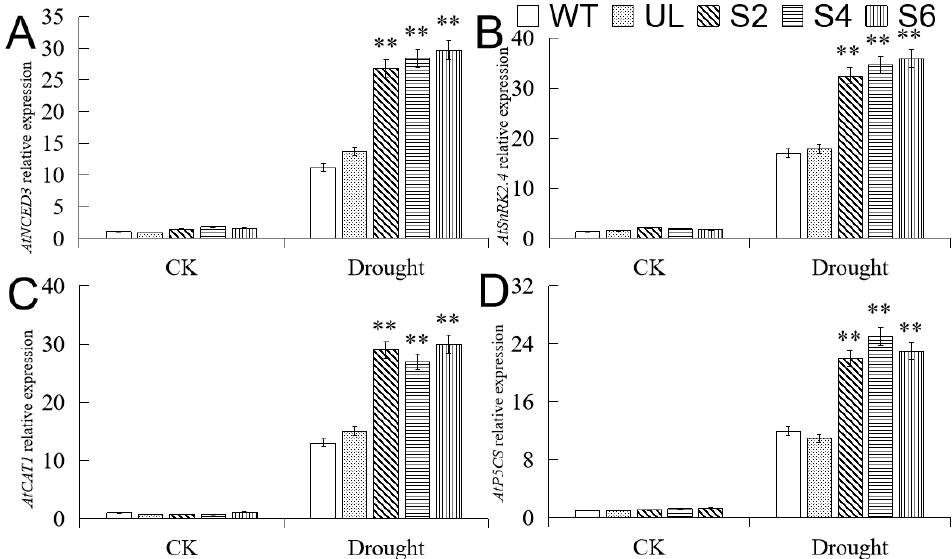
Figure 8. Relative expression levels of drought stress-related genes in WT, UL, and transgenic A. thaliana. Relative expression levels of AtNCED3 ( A ), AtSnRK2.4 ( B ), AtCAT1 ( C ), and AtP5CS ( D ). Data represent the mean of three replicates. Error bars represent standard deviation. Asterisks above error bars indicate significant difference compared to the WT line (** p ≤ 0.01).